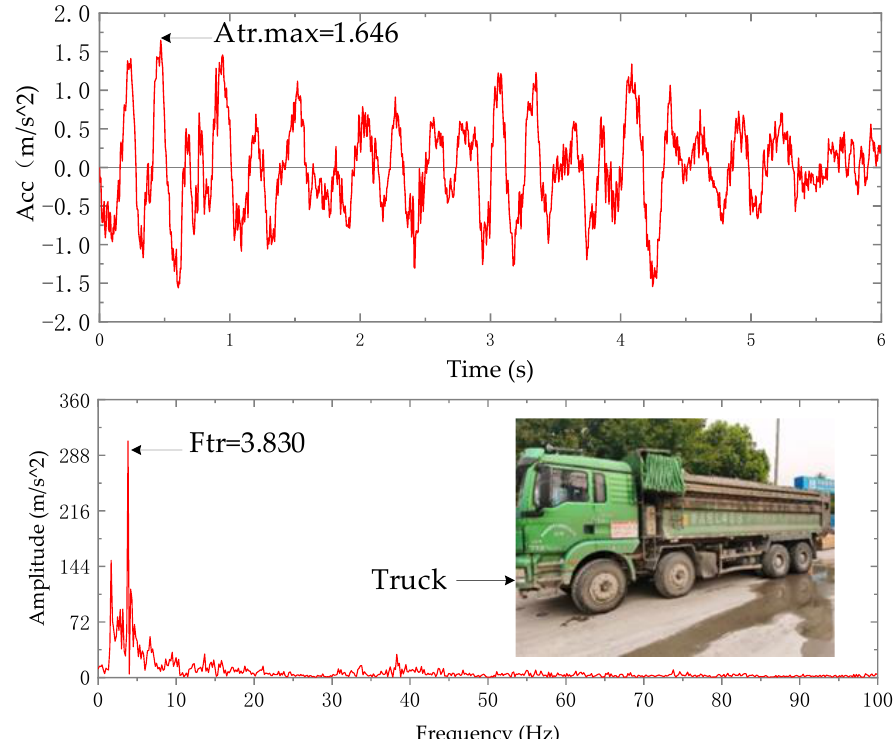
Figure 9. Temperature – strain diagram of steel assembly bracing during monitoring period (12 August to 22 November 2022).